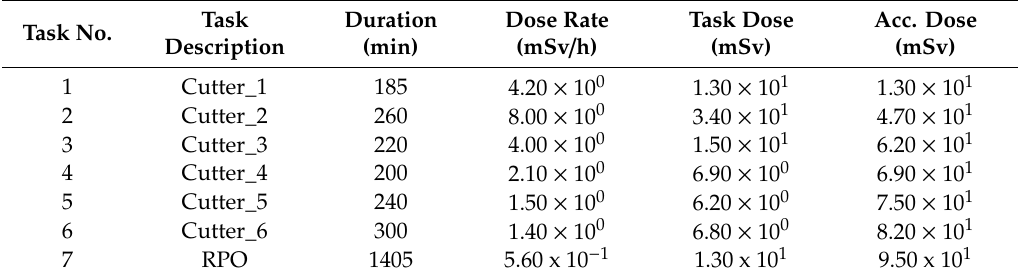
Table 14. Task information for the segmentation of the lower